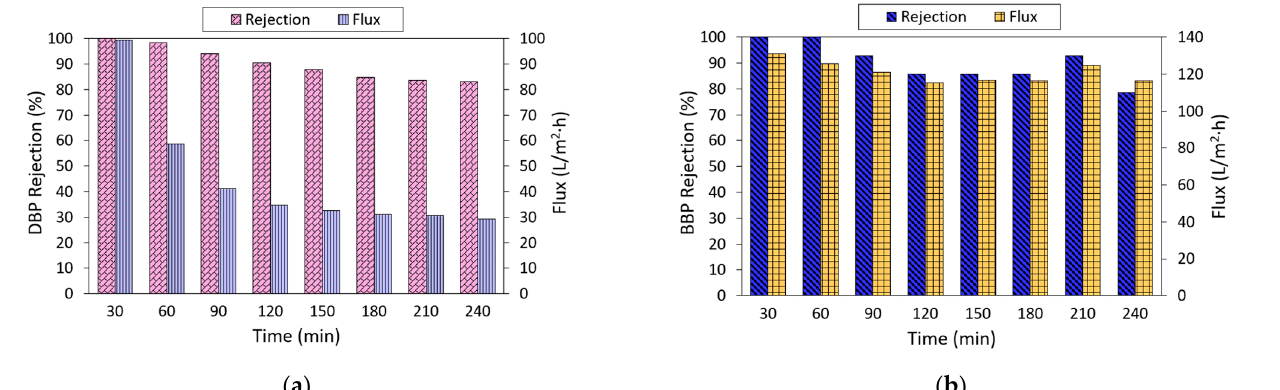
Figure 8. Performance stability of NF3 membrane as a function of time in fi ltrating ( a ) DBP (10 ppm) and ( b ) BBP (2 ppm) solution at pH ~6.3. and ( b ) BBP (2 ppm) solution at pH